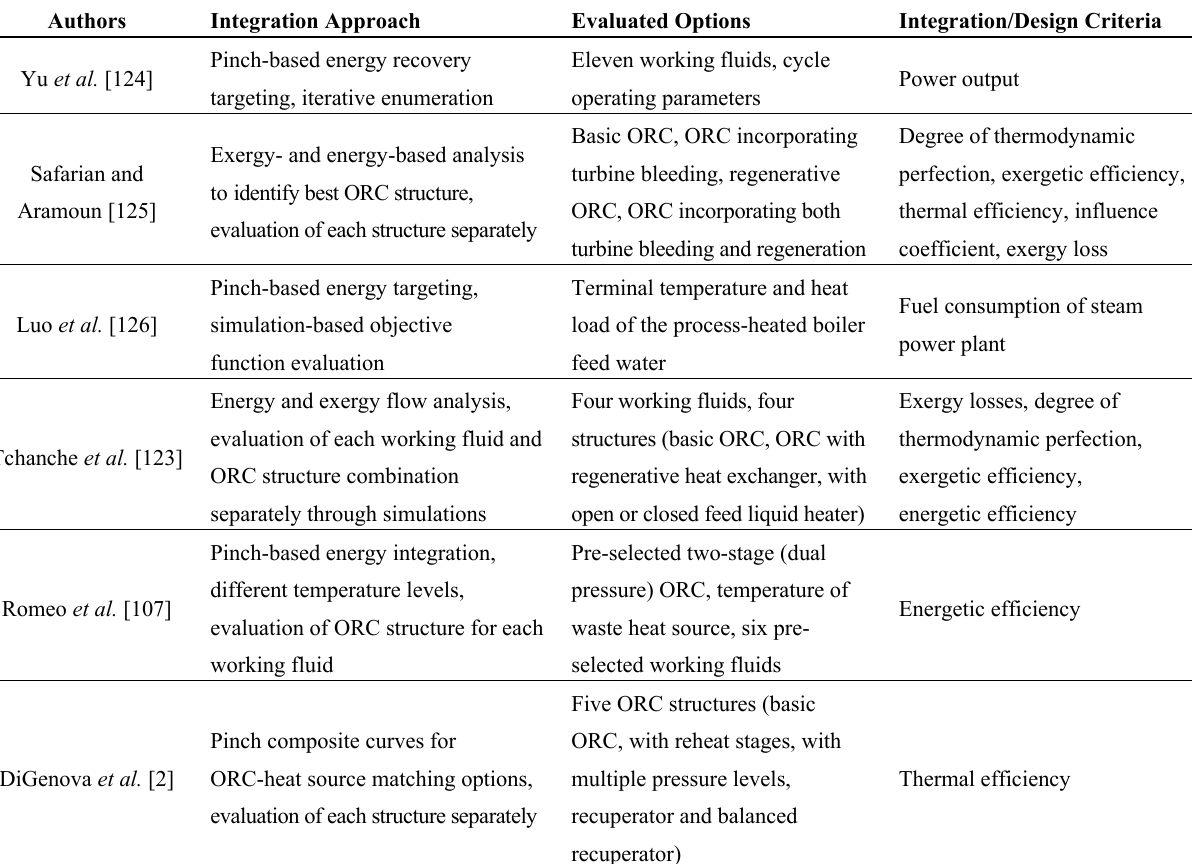
Table 11. Graphical or simulation-based heat source integration